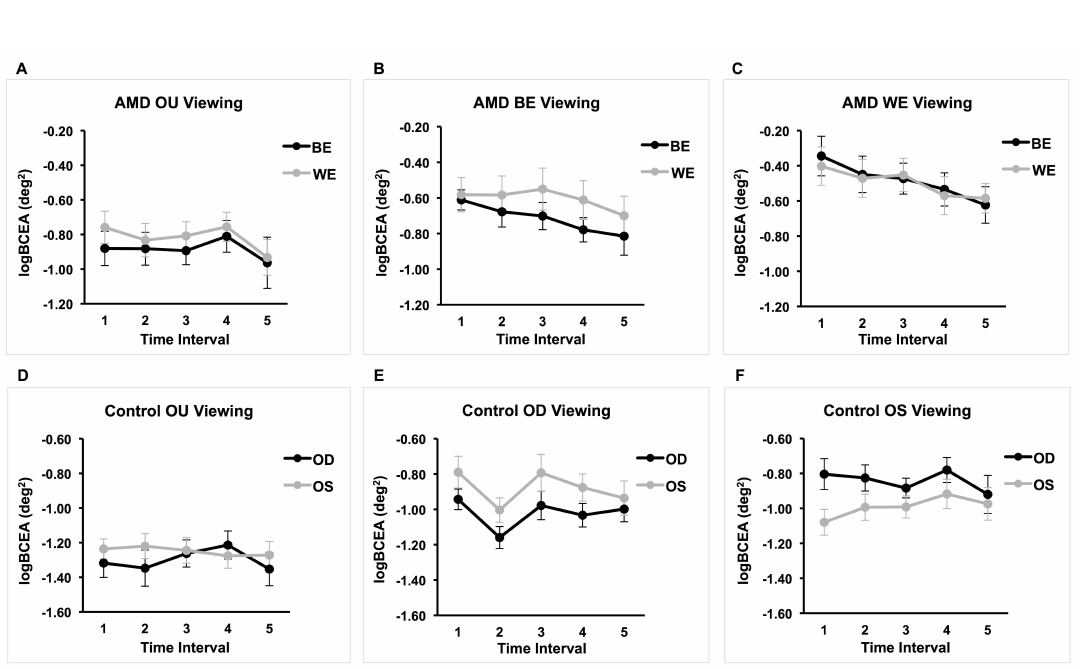
Figure 1. Mean logBCEA for five 3-second intervals for AMD and control groups under binocular and monocular viewing conditions. Fixation stability of both covered and viewing eyes are plotted for each viewing condition. ( A ) n = 17; ( B ) n = 16; ( C ) n = 15; ( D ) n = 17; ( E ) n = 16; ( F ) n =